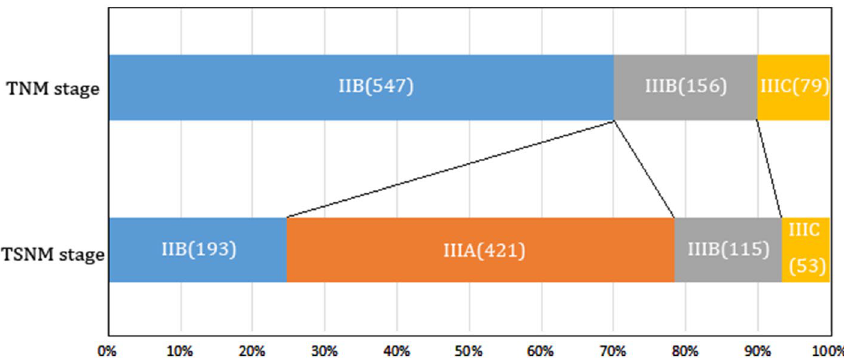
Figure 7. Patients distribution of different classification system. In the TNM staging system, patients were staged from IIB to IIIC, and the largest subgroup was IIB stage, however, there was no IIIA stage. In the mTSNM staging system, patients were continuously distributed from IIB to IIIC stage and the largest subgroup was IIIA